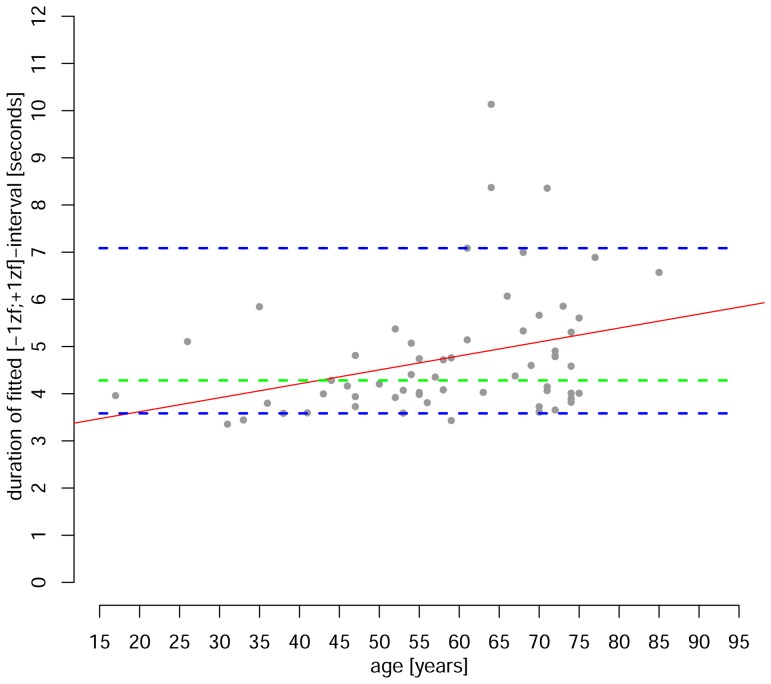
Distribution of durations found for the interval Ιp =  {v |−1≤zf(TTPv) ≤+1} are depicted in relation to the patient age.An increase of approx. 30 ms per year on average was obtained from the linear regression analysis (red trend line). The dashed horizontal, blue lines mark the 5%- (lower) and 95%- (upper) percentiles of the Ιp - interval, where the median shows at 4.3 s (green dashed horizontal line).